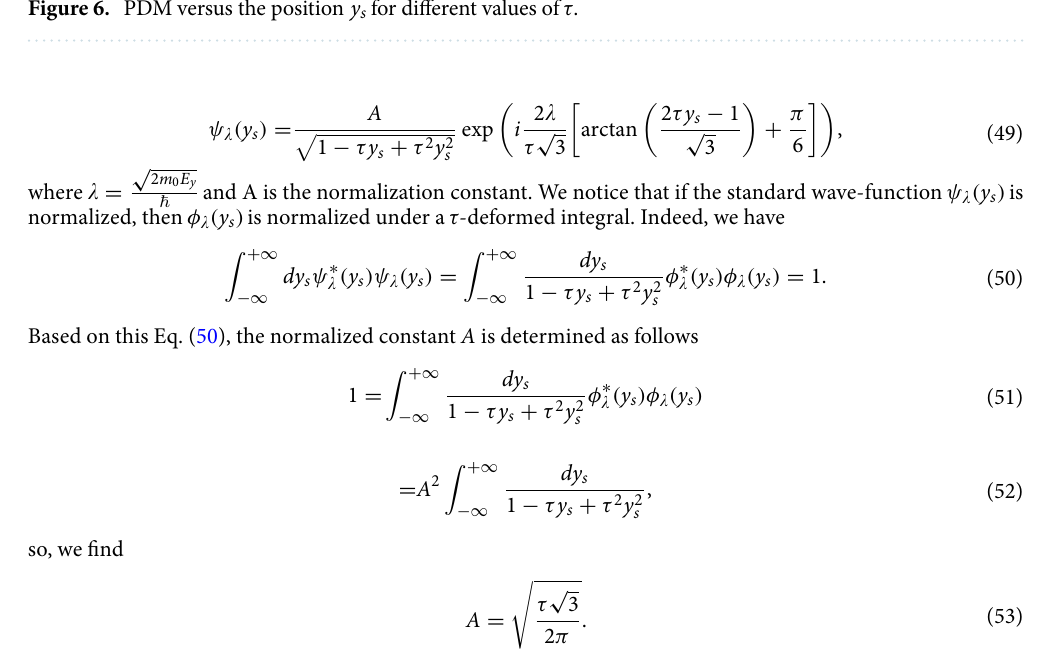
Figure 6. PDM versus the position y s for different values of τ